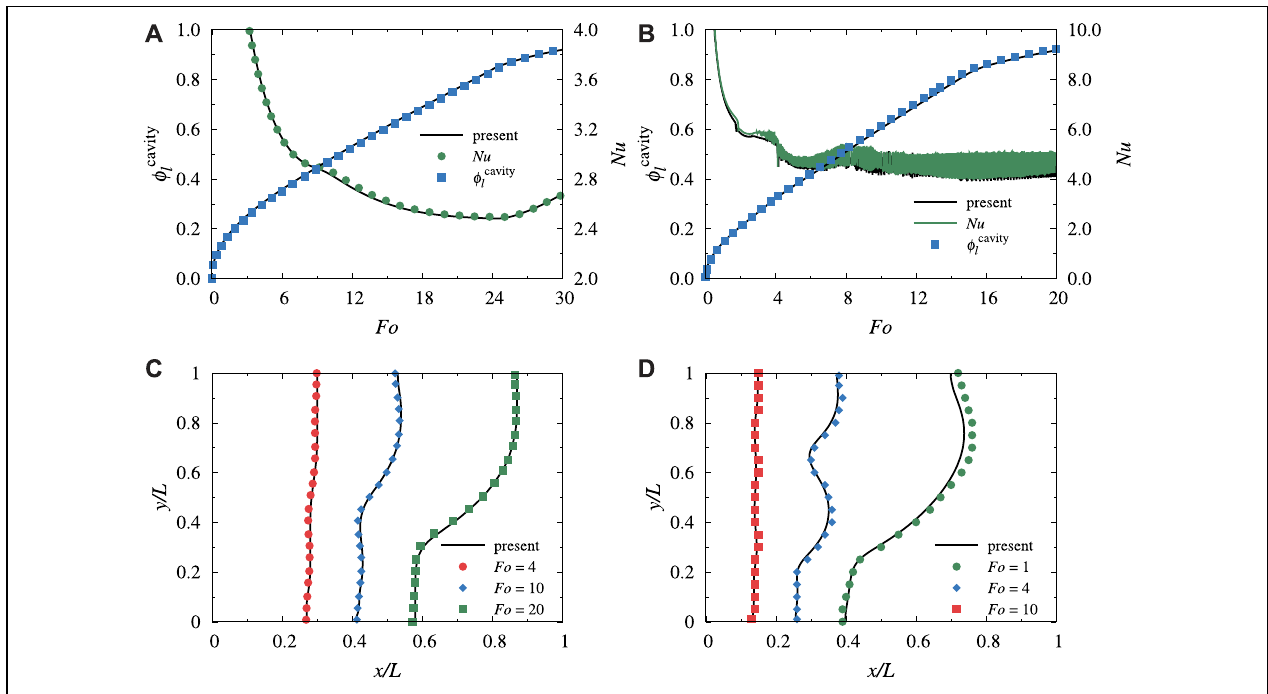
FIGURE 1 | The comparison of results for the average Nusselt number along the left wall Nu and the liquid phase fraction of the cavity ϕ cavity l versus the Fourier number Fo (A) : Ra = 2.5 × 10 4 , (B) : Ra = 2.5 × 10 5 ), the position of the solid/liquid interface (C) : Ra = 2.5 × 10 4 , (D) : Ra = 2.5 × 10 5 ).